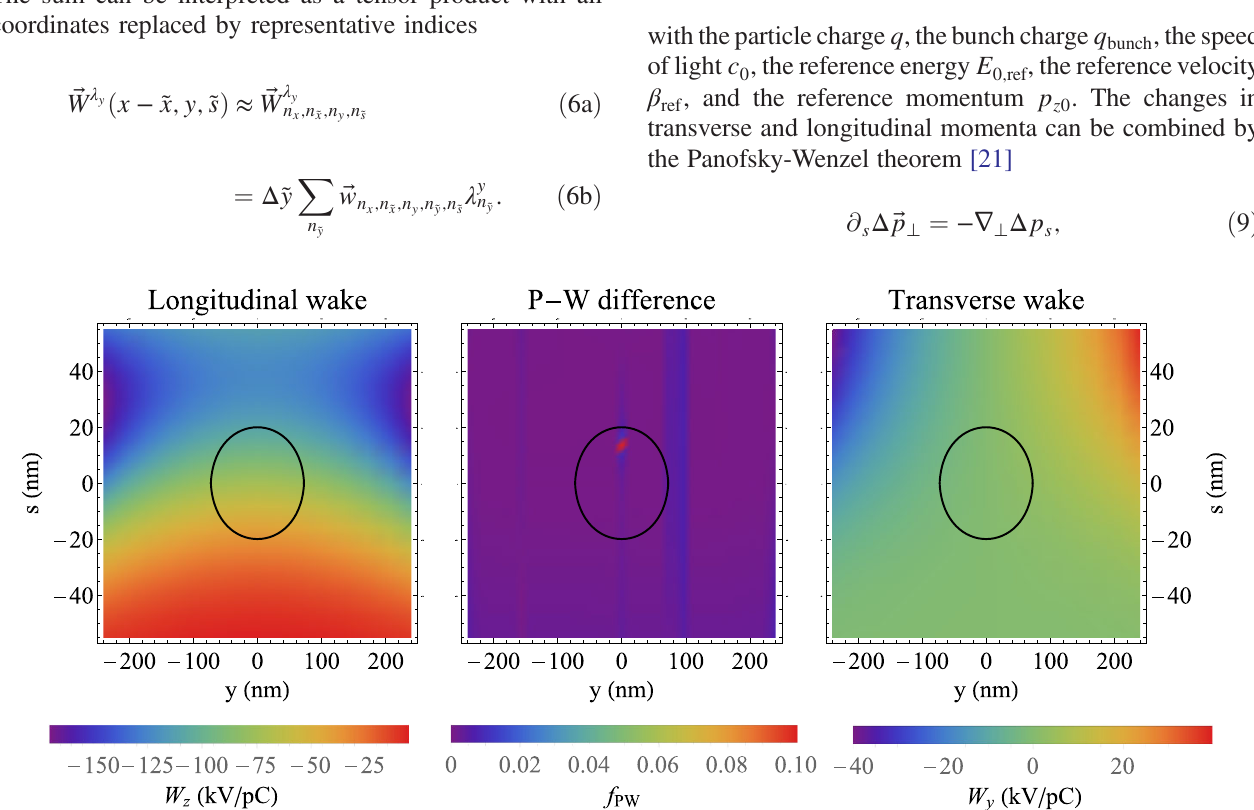
FIG. 3. Longitudinal and transverse wake potential per grating period in the left and right plot, respectively. The plot in the center shows the normalized difference between the left end the right-hand side of the Panofsky-Wenzel theorem [Eq. (11)] calculated for the simulated data of a Gaussian bunch distribution with standard deviation given by the black